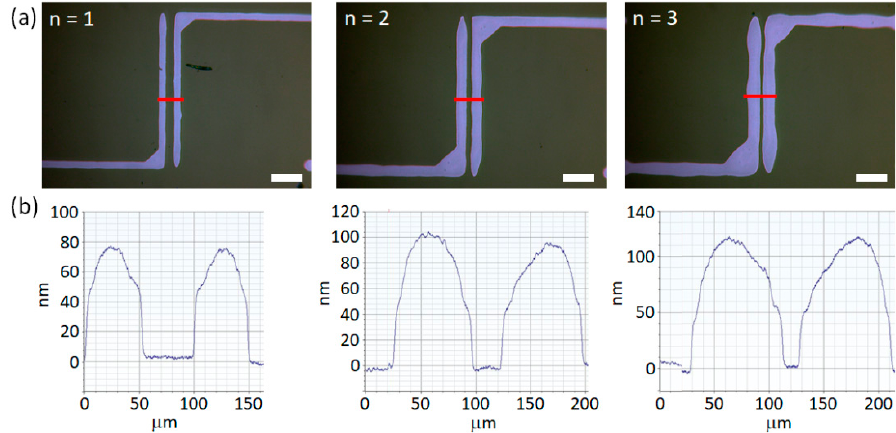
Figure 8. ( a ) Optical microscope images of DGP overprints on plasma-treated SiO 2 surface with different number of printed layers ( n ). ( b ) Cross-section profiles of the respective overprints. A = 250 V, B = 200 V, f = 100 Hz, s = 100 µ m. Scale bar equal 200 µ m.